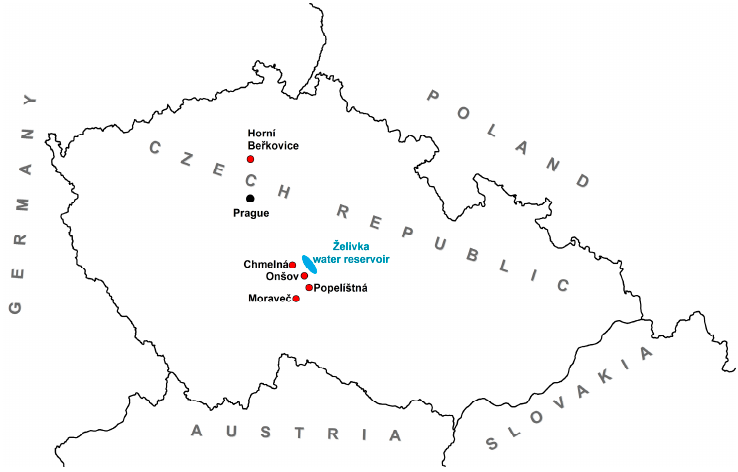
Figure 1. Location of pilot sites.